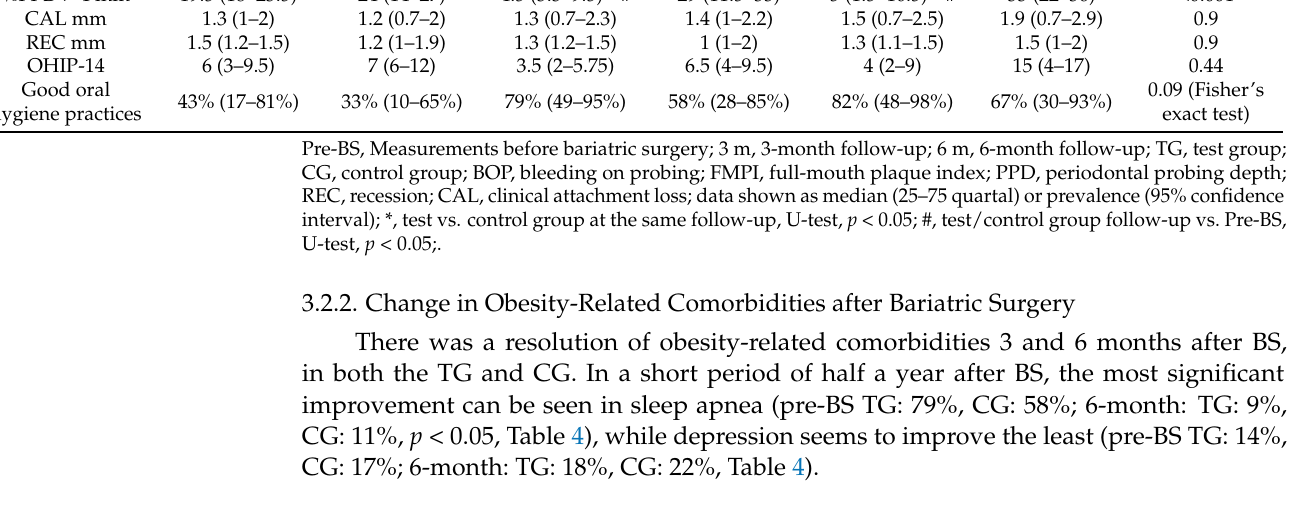
Table 4. Obesity-related parameters and comorbidities before and after bariatric